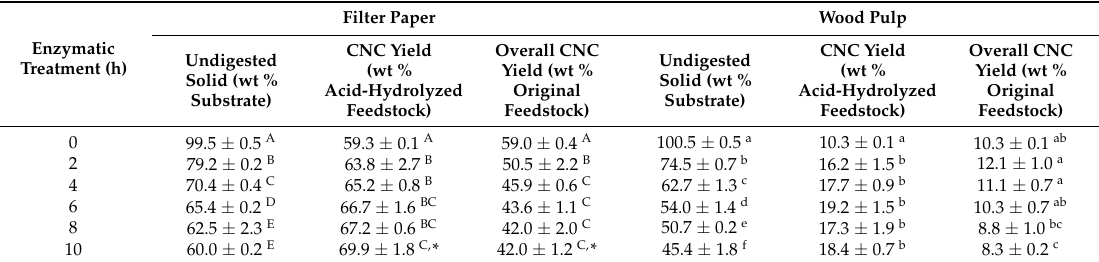
Table 1. Undigested solid and cellulose nanocrystal (CNC) yields from cellulase cocktail treated filter paper and wood pulp.